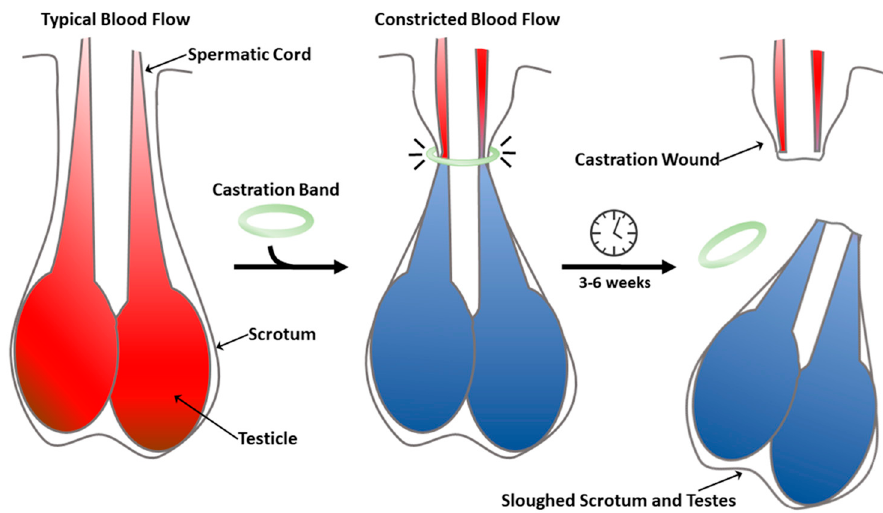
Figure 1. Castration procedure using elastic castration bands.